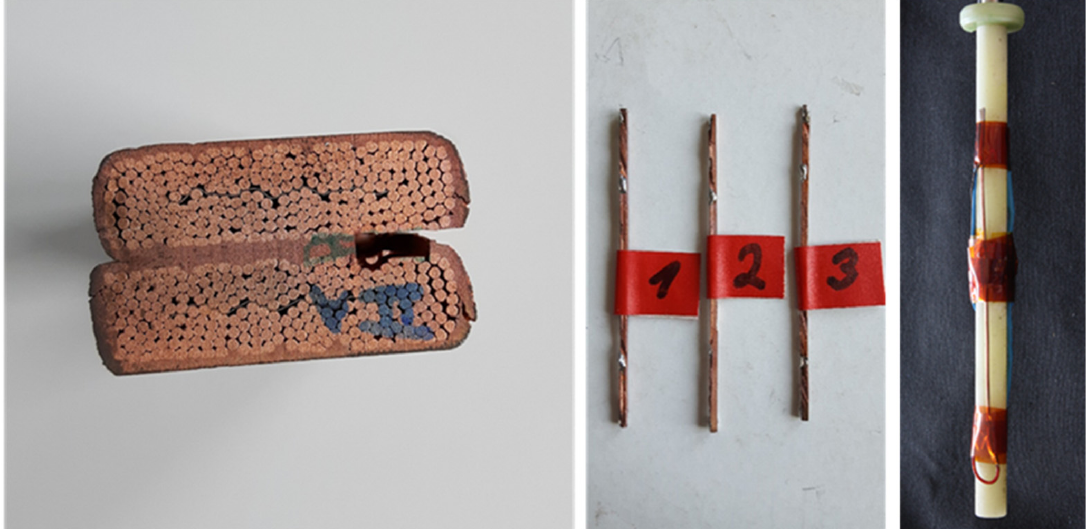
Figure 11. Samples extracted from the Cu coating of a dummy joint for the RRR measurements.